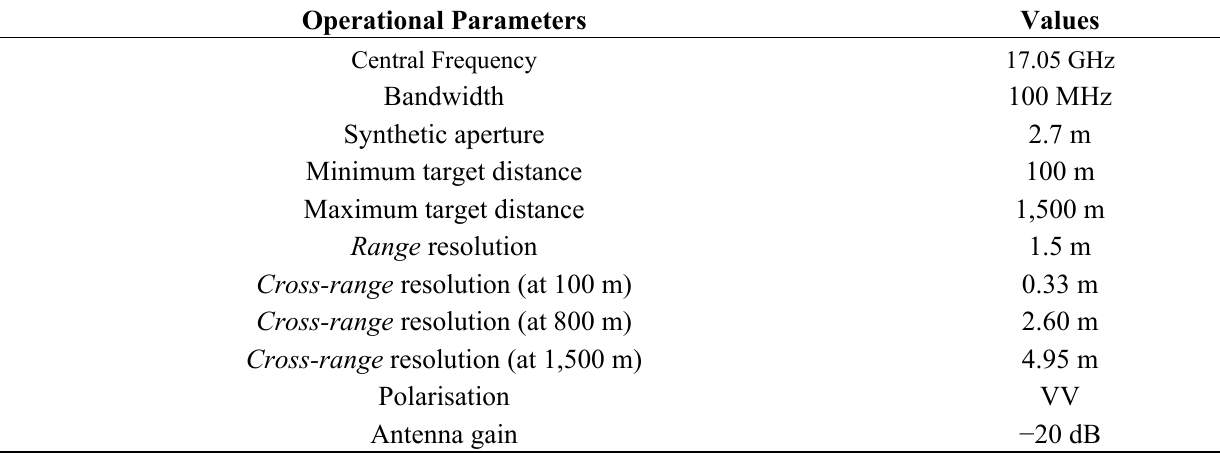
Table 1. Summary of the main operational parameters of the radar measurement